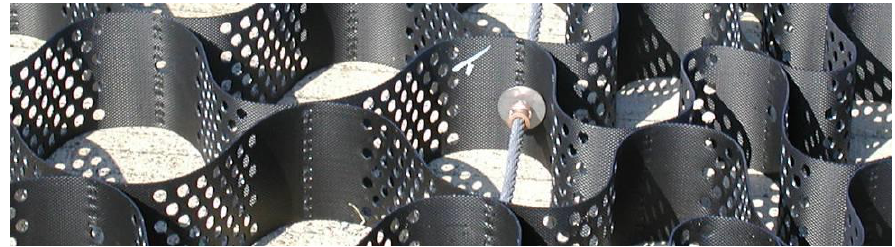
Figure 7. Photo showing typical installed copper stop sleeve/stainless steel washer bearing assembly inside an empty